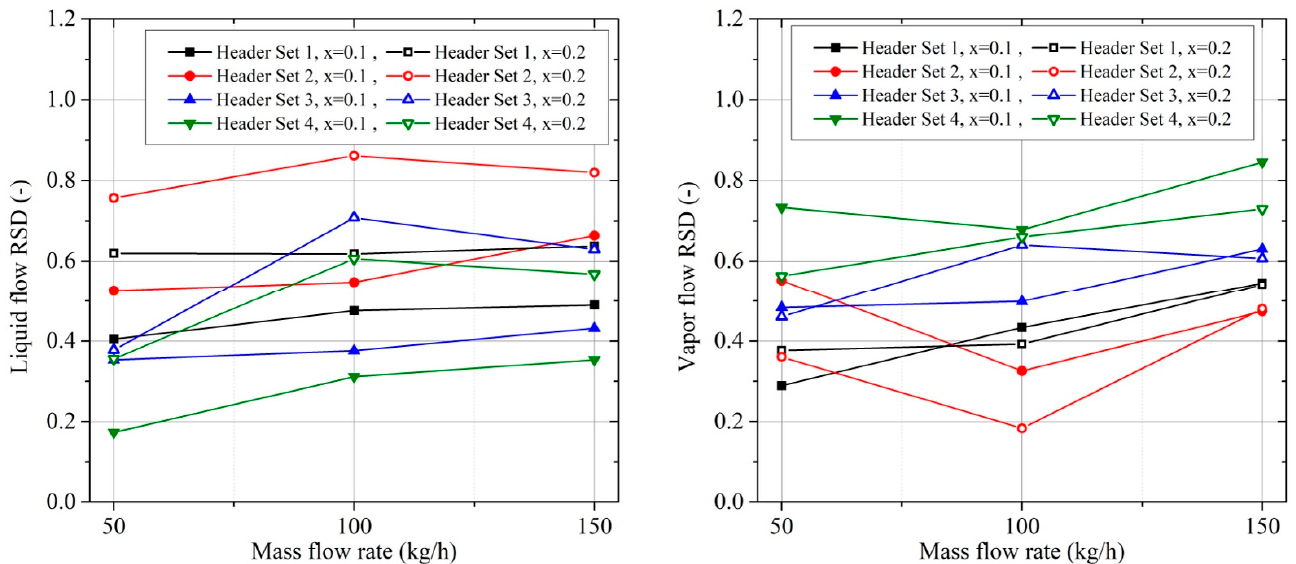
Figure 6. Relative standard deviation for the four vertical headers.